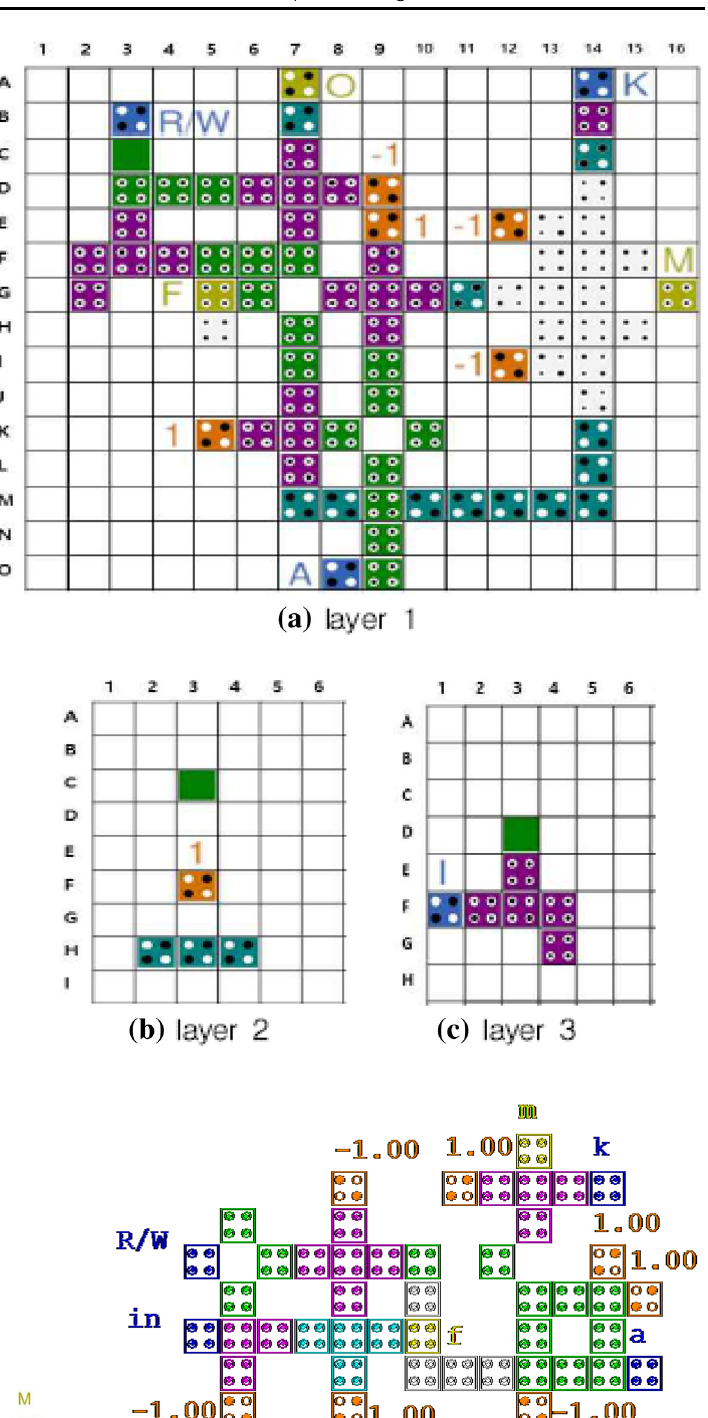
Fig. 9 The designed 1-bit CAM circuit in [6]